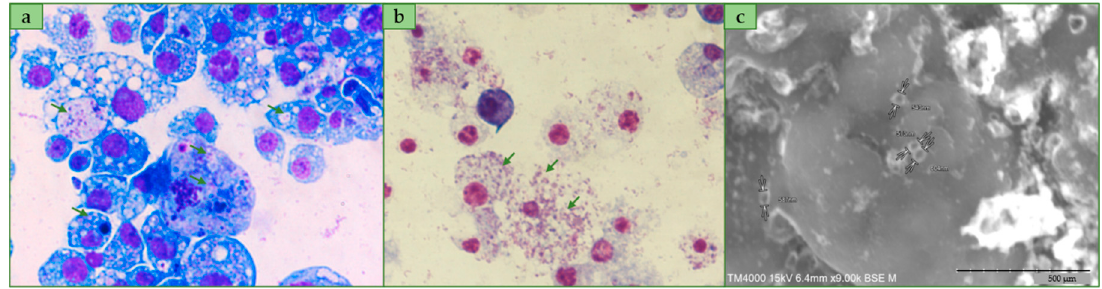
Figure 1. wChem PL13 grown (arrowed) in S2 cell-line. ( a , b ): Diff-Quik staining, ×1500 showing the intravacuolar location and bacterial load of the wChem PL13 strain, respectively. ( c ): scanning microscopic examination of the wChem PL13 strain.